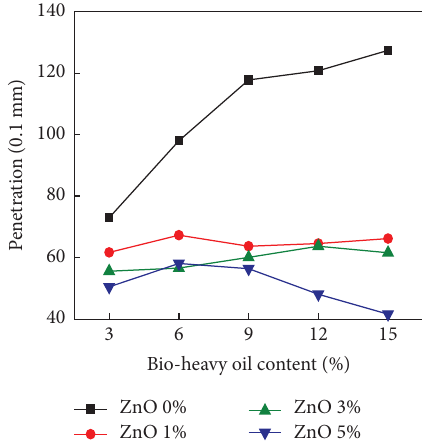
Figure 5: Penetration under diferent bio-asphalt